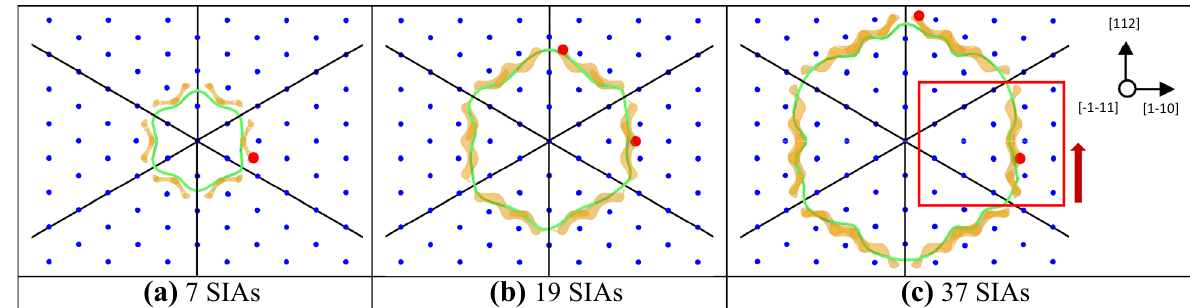
Figure 1. Charge density maps for the three dislocation loops considered in this study. The green line shows the position of dislocation line of the dislocation loop identified using OVITO with DXA method. The orange isosurfaces correspond to a charge density equal to 9.03 × 10 –6 e/Å 3 . The red points reveal the different initial positions for the impurity. The red square highlights the zone (perpendicular to the graph’s plane) used for an in-depth analysis in the results section, while the red arrow shows the corresponding viewing direction. The images are created with OVITO [‘https:// www. ovito. org/’ version 3.0.0-dev] 27